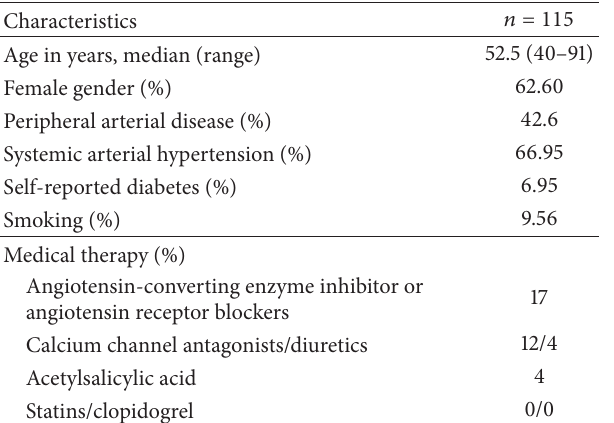
Table 1: Demographical and clinical characteristics of the study population.